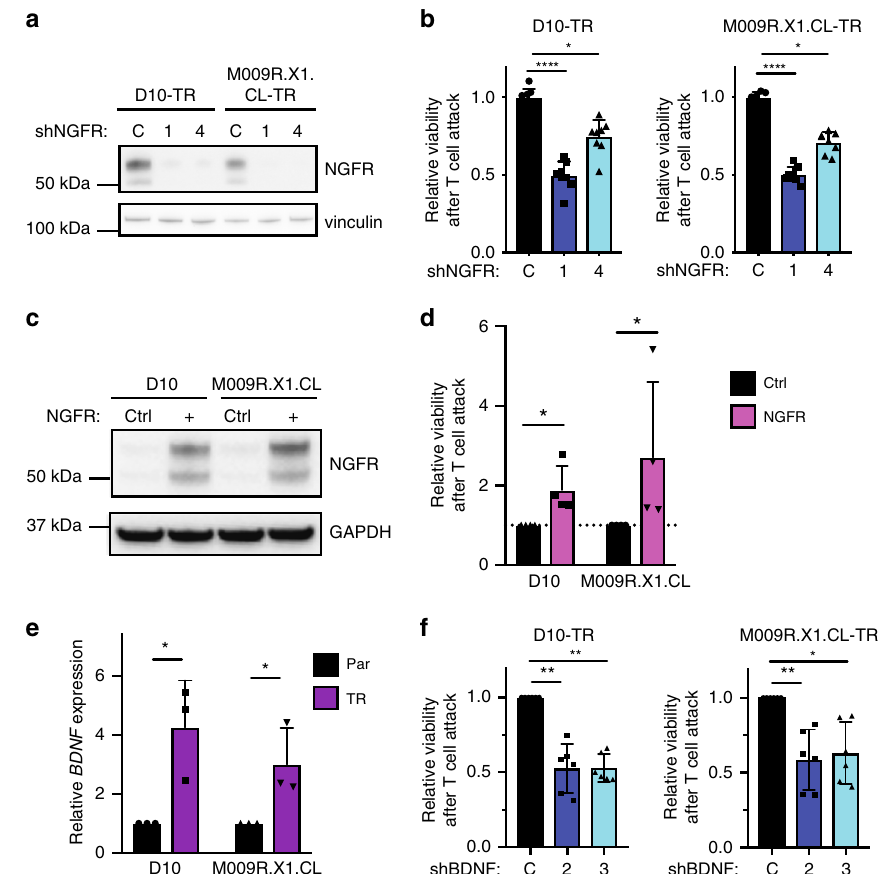
Fig. 6 Genetic perturbation of NGFR modulates T cell sensitivity. a Western blot analysis of indicated cell lines transduced with a control hairpin or one of two short hairpins targeting NGFR. Vinculin was used as a loading control. One blot of two independent replicates is shown (the other can be found in Source data). b Quanti fi cation of MART-1 T cell cytotoxicity in TR cell lines relative to Ctrl T cells (1:1 ratio tumor cell: T cell) in the presence of absence of shNGFR. Cells were loaded with 100nM MART-1 peptide prior to the assay, and cytotoxicity was normalized to shCtrl cell survival after MART-1 T cell attack. Error bars represent S.D. of four independent experiments with two technical replicates. Statistical analysis by Kruskal – Wallis test; * p <0.05, **** p <0.001. c Western blot analysis on D10 and M009R.X1.CL cells transduced with a control ORF or an NGFR-RFP ORF. GAPDH was used as a loading control. One blot of two independent replicates is shown (the other can be found in Source data). d Quanti fi cation of cell survival by fl ow cytometry after T cell attack in vitro in control or NGFR-ORF cells. Error bars represent S.D. of four independent experiments. Statistical analysis by Mann – Whitney, * p <0.05. e mRNA expression of BDNF in parental and TR cells. Error bars represent S.D. of pooled analysis of three independent replicates. Analysis by unpaired t -test; * p <0.05. f Quanti fi cation of cytotoxicity in TR cell lines relative to shCtrl cells after T cell attack (1:1 ratio tumor : T cell) in the presence or absence of shBDNF. Error bars represent S.D. of six independent experiments. Statistical analysis by Kruskal – Wallis test; * p <0.05, ** p <0.01. Source data are provided as a Source Data fi